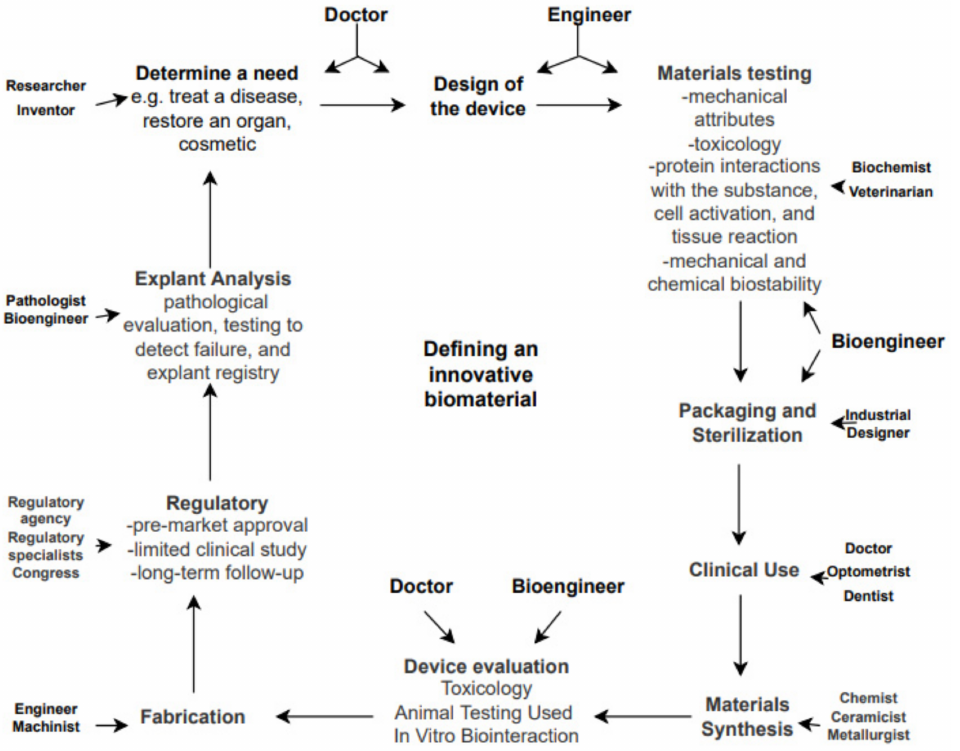
Figure 2. Disciplines involved in biomaterials science and the path from a need to a manufactured medical